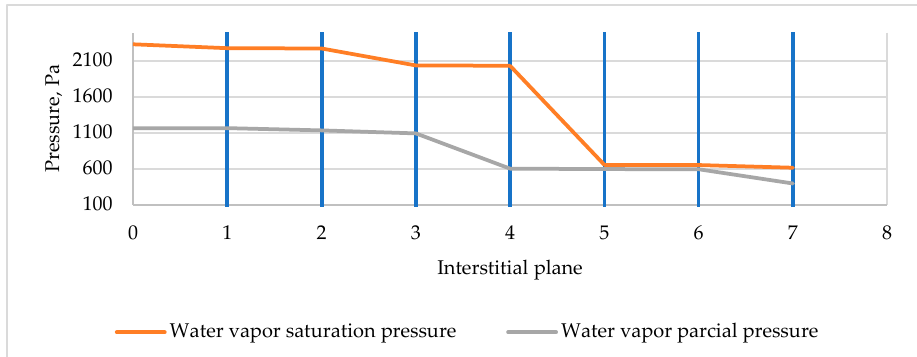
Figure 10. Partial and saturation pressures in interstitial planes for wall type1 (1. interior surface; 2. wallpaper/plasterboard; 3. vapor barrier/plasterboard; 4. mineral wool/vapor barrier; 5. plaster/mineral wool; 6. dolomite/plaster; 7. exterior wall surface). Therefore, relative humidity calculations for interstitial planes on both sides of the